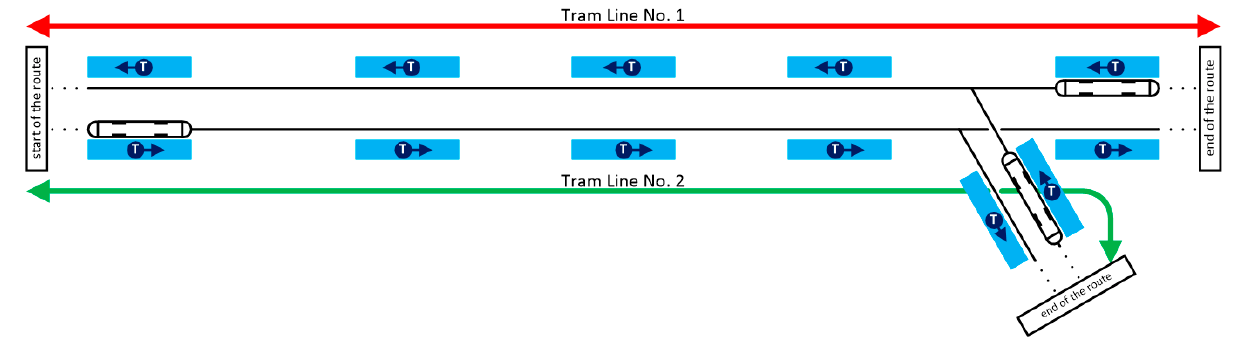
Energies 2022 , 15 , x FOR PEER REVIEW Figure 9. Sharing a section of a tram route by two sample tram lines. Figure 9. Sharing a section of a tram route by two sample tram lines.